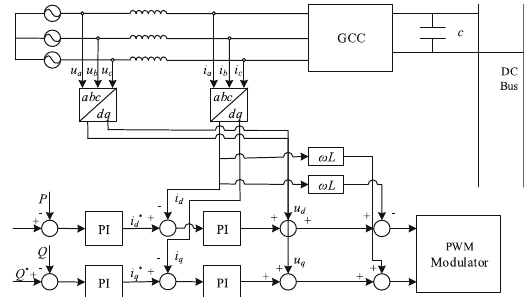
Fig. 7 Vector decoupling direct current control strategy